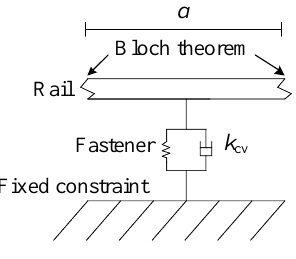
Figure 6. The periodic track model.